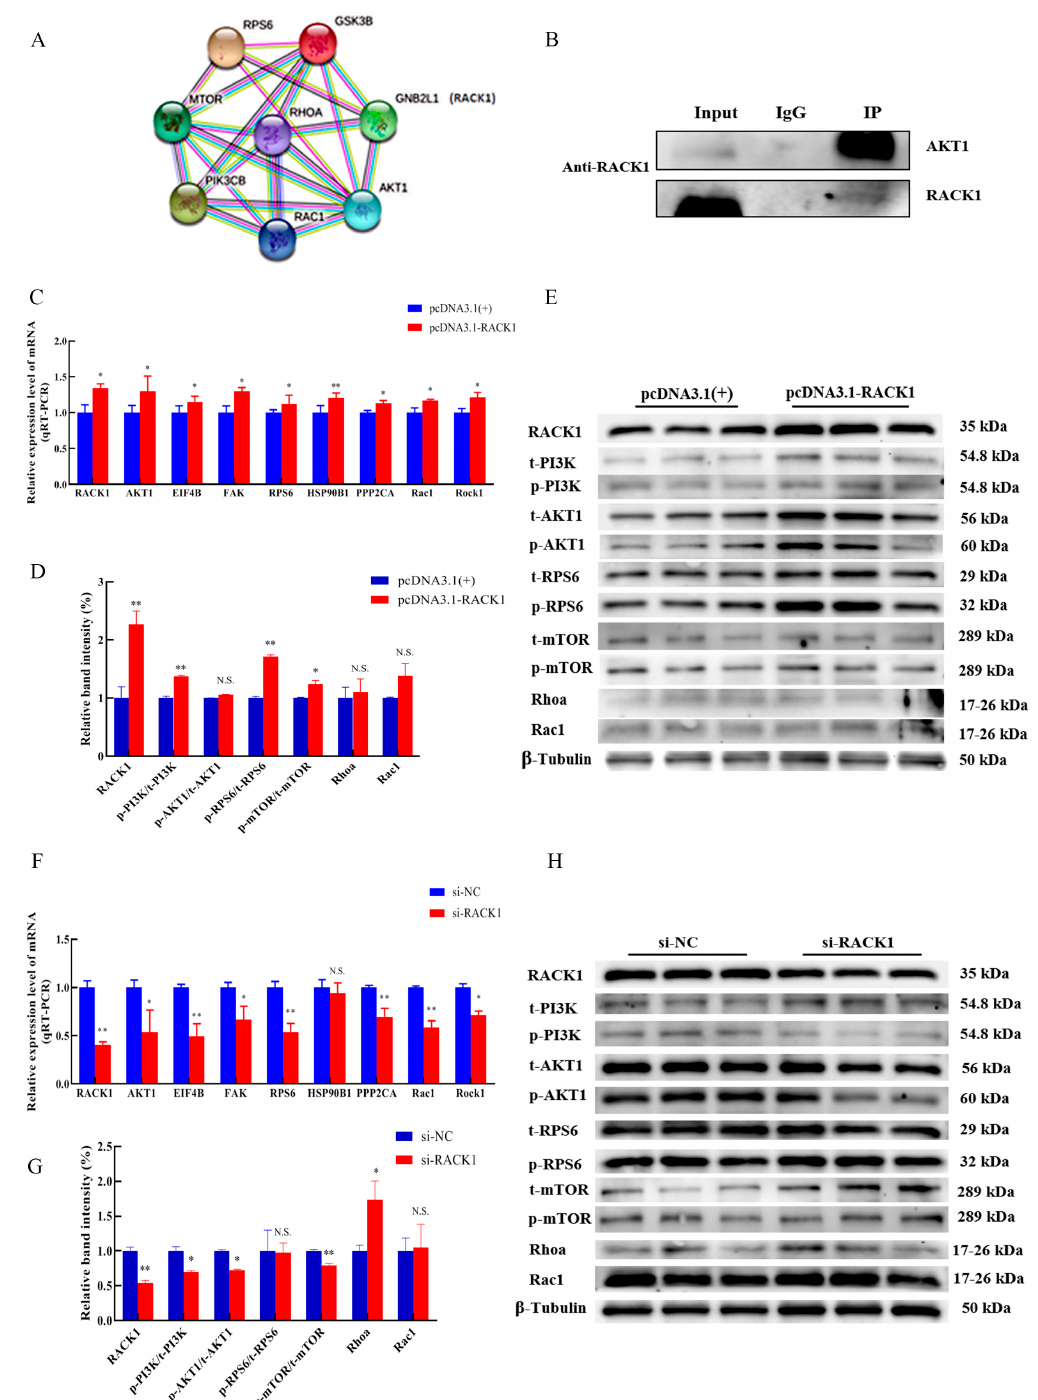
Figure 7. Prediction of the interaction between the RACK1 gene and the PI3K/AKT pathway. ( A ) STRING predicts the interaction between the RACK1 protein and key proteins of the PI3K/AKT pathway. ( B ) Co-IP confirms the interaction between RACK1 protein and AKT1 protein. ( C ) qRT- PCR detection of transcription levels of key genes in the PI3K/AKT/mTOR pathway after overex- pression of RACK1. ( D , E ) Changes in expression of key proteins in the PI3K/AKT/mTOR path- way after overexpression of RACK1. ( F ) qRT-PCR detection of transcription level of key genes of PI3K/AKT/mTOR pathway after inhibition of RACK1. ( G , H ) Changes in the expression of key proteins of PI3K/AKT/mTOR pathway after RACK1 inhibition. Differences between groups were statistically analyzed using Student’s t -test. p < 0.05 was considered statistically significant (* p < 0.05 and ** p < 0.01). And N.S., not significant ( p >